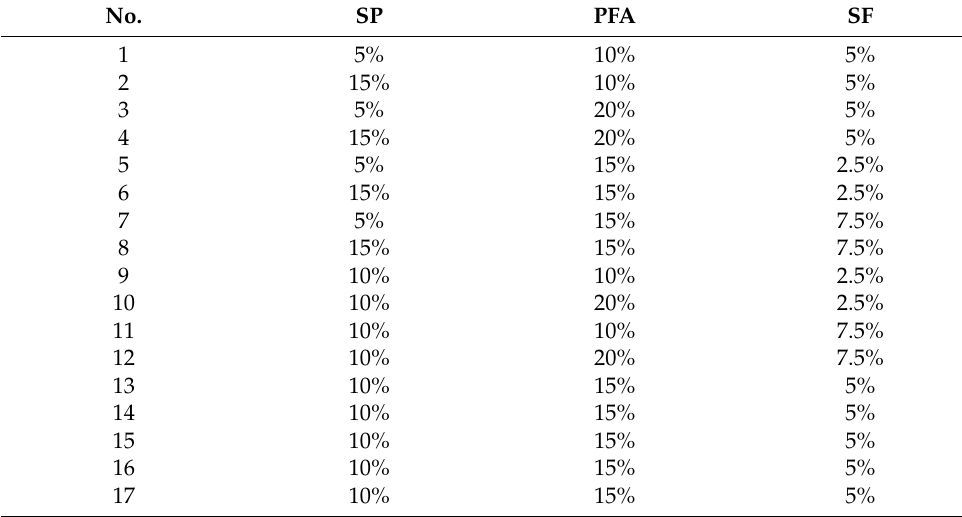
Figure 4. The test of compressive strength. 3. Results and Discussion 3.1. Box–Behnken Experiment Design and Significance Test 3.1.1. Box–Behnken Experiment Design The Box–Behnken test factors and levels are shown in Table 5, using the uniaxial compressive strength values as the response values and the SP content (X 1 ), PFA content (X 2 ), and SF content (X 3 ) as the investigating factors. The test results and analysis are shown in Table 6. Table 5. Factors and levels of Box–Behnken experiments. Factors